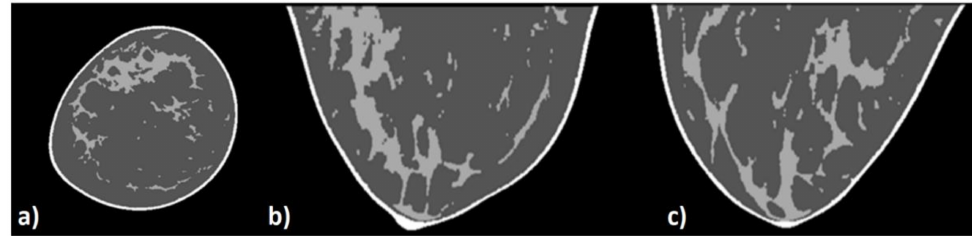
Figure 3. An example of an axial ( a ), sagittal ( b ), and coronal ( c ) slice of the patient breast after the voxel classification